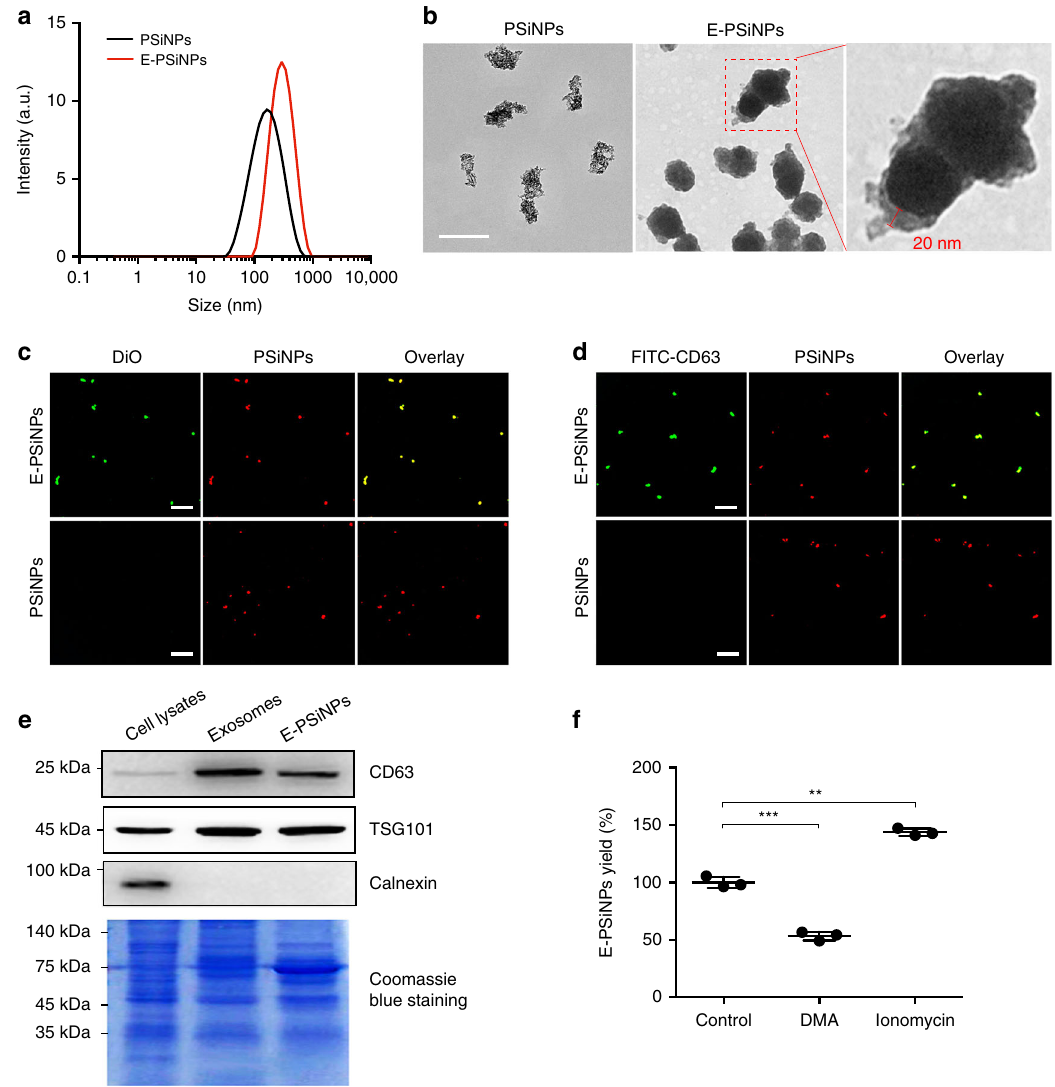
Fig. 3 Evaluation of exosomes sheathed on PSiNPs in E-PSiNPs. a Hydrodynamic diameter of PSiNPs and E-PSiNPs by DLS analysis. b TEM images of PSiNPs and E-PSiNPs. Scale bar: 200 nm. c Colocalization of DiO (green) and PSiNPs (red) in E-PSiNPs by confocal microscopy. Scale bar: 20 μ m. d Colocalization of CD63 (green) and PSiNPs (red) in E-PSiNPs by confocal microscopy. Scale bar: 20 μ m. e Immunoblotting analysis of exosome markers (TSG101 and CD63) and ER marker (calnexin) expressed in E-PSiNPs exocytosed from Bel7402 cells. f Yield of E-PSiNPs when Bel7402 cells were pretreated with 200 μ g mL − 1 PSiNPs for 6 h and then incubated in fresh medium containing 15 nM DMA or 10 μ M ionomycin for 16 h by ICP-OES. Data were represented as mean ± SD ( n = 3). ** P < 0.01, *** P < 0.001 (one-way ANOVA with Fisher ’ s LSD test). Source data are provided as a Source Data fi